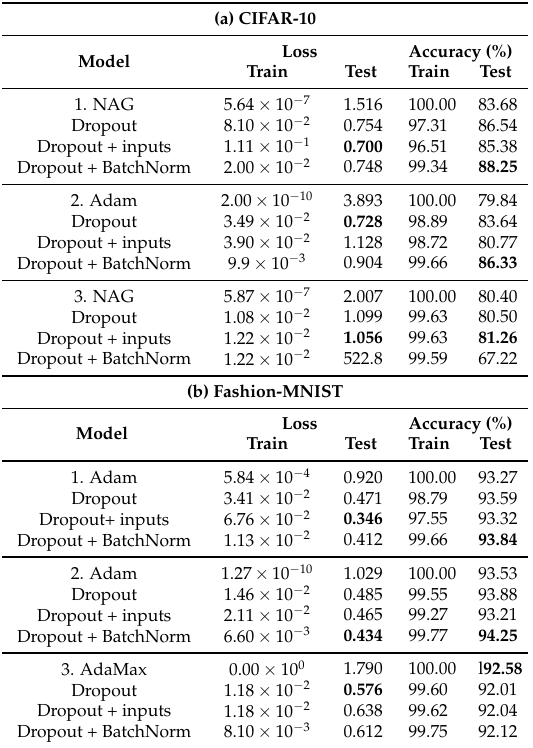
Table 8. Performance of models that employ Dropout